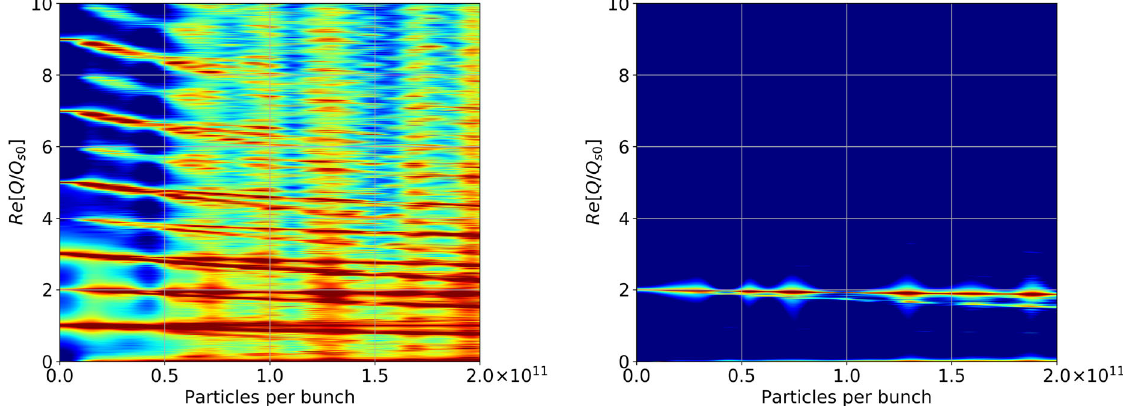
FIG. 6. Real part of normalized mode-frequency shift obtained with the results of SBSC with a pure inductive impedance above transition. The left-hand side has been obtained by summing the first ten modes, the right-hand side has been obtained by using only the rms bunch length.